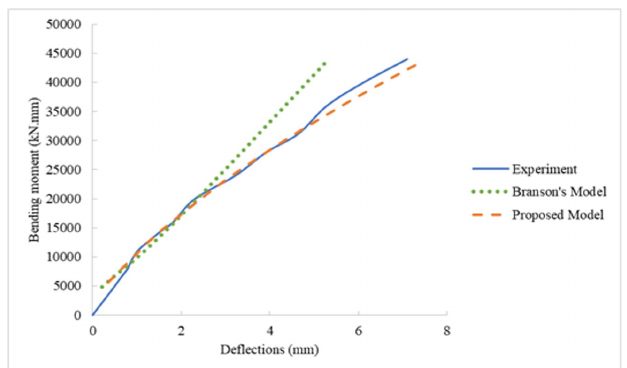
Figure 7. Experimental results from Fernandes [32] compared with Branson’s model and the proposed